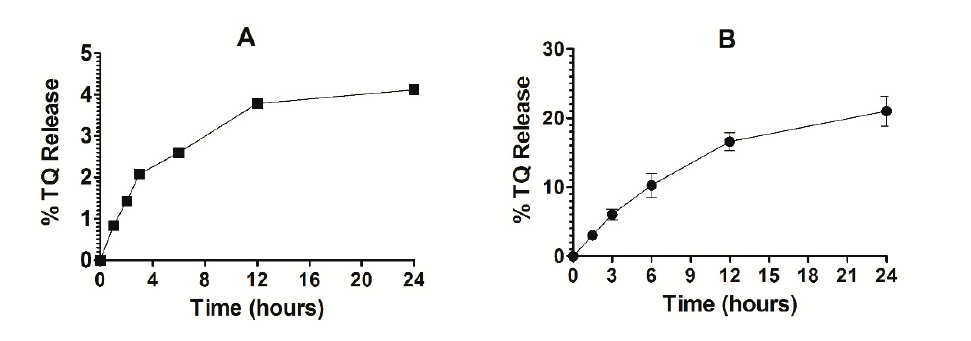
Figure 7. Stability and release kinetics of Lip-TQ. ( A ) Stability of Lip-TQ in deionized water, ( B ) Re- lease kinetics of TQ from the liposomes into the serum.